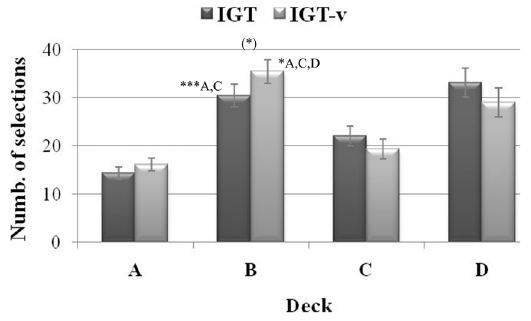
Figure 4. Selection from each deck as a function of IGT version for Impulsivity levels. Mean number of cards chosen from each deck, in the original (IGT, on the left) and modified (IGT-v, on the right) task versions for participants with Low vs. High. Impulsivity levels. Vertical bars denote + / 2 0.95 confidence intervals, ** p # 0.01.